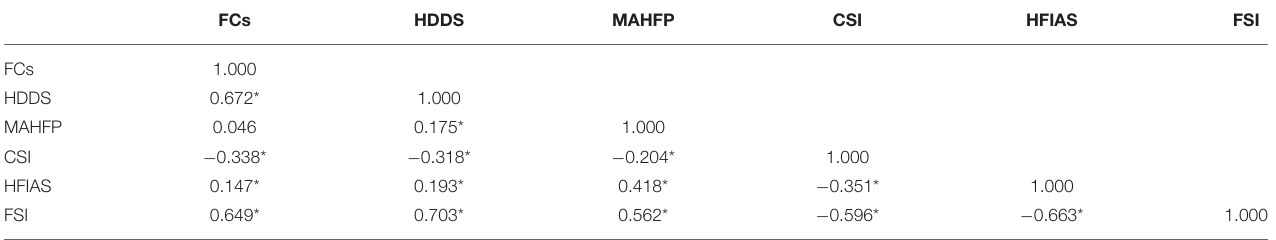
TABLE 4 | Spearman’s correlation coefficients between food security indicators (*statistically significance at 0.05 threshold).